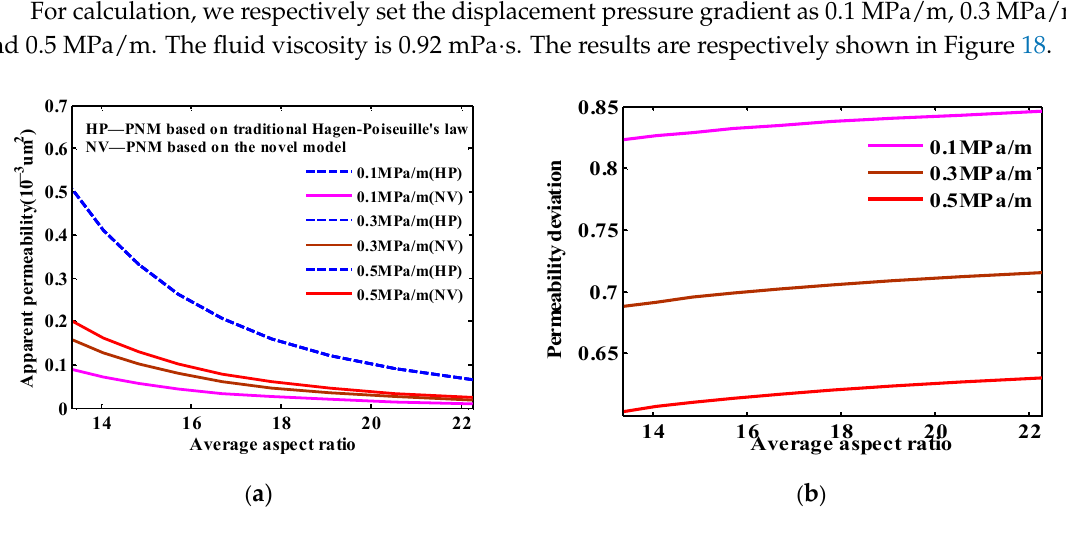
Figure 18. Relationship between apparent permeability versus average aspect ratio at different ∇ P: ( a ) Apparent permeability; ( b ) Permeability deviation.